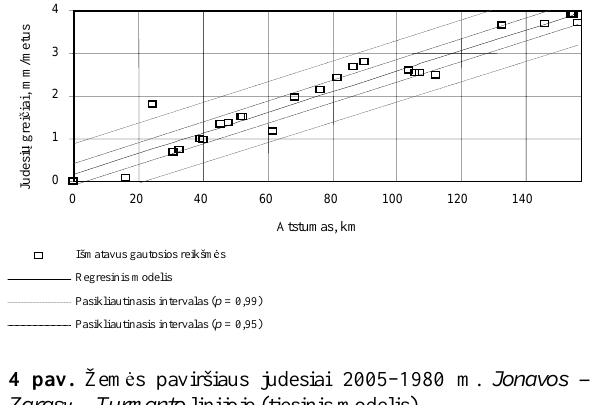
Fig 4. Earth surface movements (2005–1980) in line Jonava – Zarasai – Turmantas (linear model)